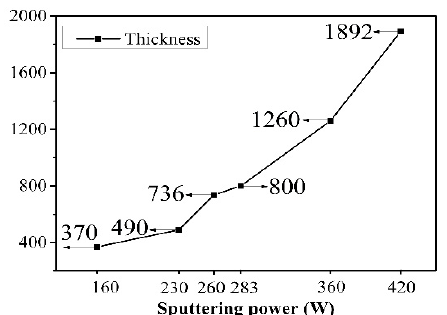
Figure 4. Line charts of the thickness of Fe films as a function of the sputtering power.